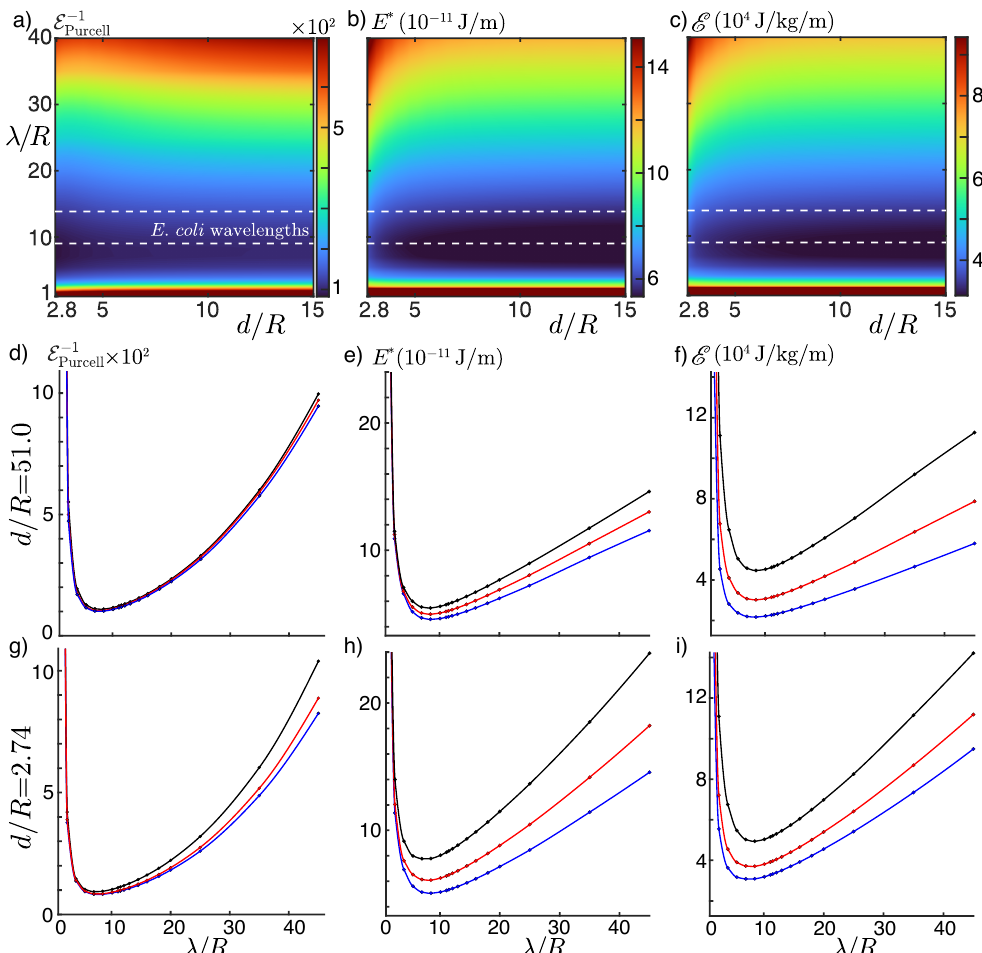
Figure 12. Energy cost as a function of wavelength and boundary distance. The top row shows three energy cost measures as a function of helical wavelength λ / R and boundary distance d / R , where R is the helical radius. Typical E. coli wavelengths are indicated with the dashed white lines whose range is close to the optimal wavelength predicted by these energy cost measures. The second and third rows show line plots at distances far from ( d / R = 51.0) and near ( d / R = 2.74) the boundary to assess the wavelength dependence of each measure at those distances. The solid circles are numerical simulations, and the solid curves are spline fits to the numerical data. The three curves show the maximum (black), the median (red), and the minimum (blue) among all cell bodies simulated. All these plots have the optimal flagellar wavelength λ / R ≈